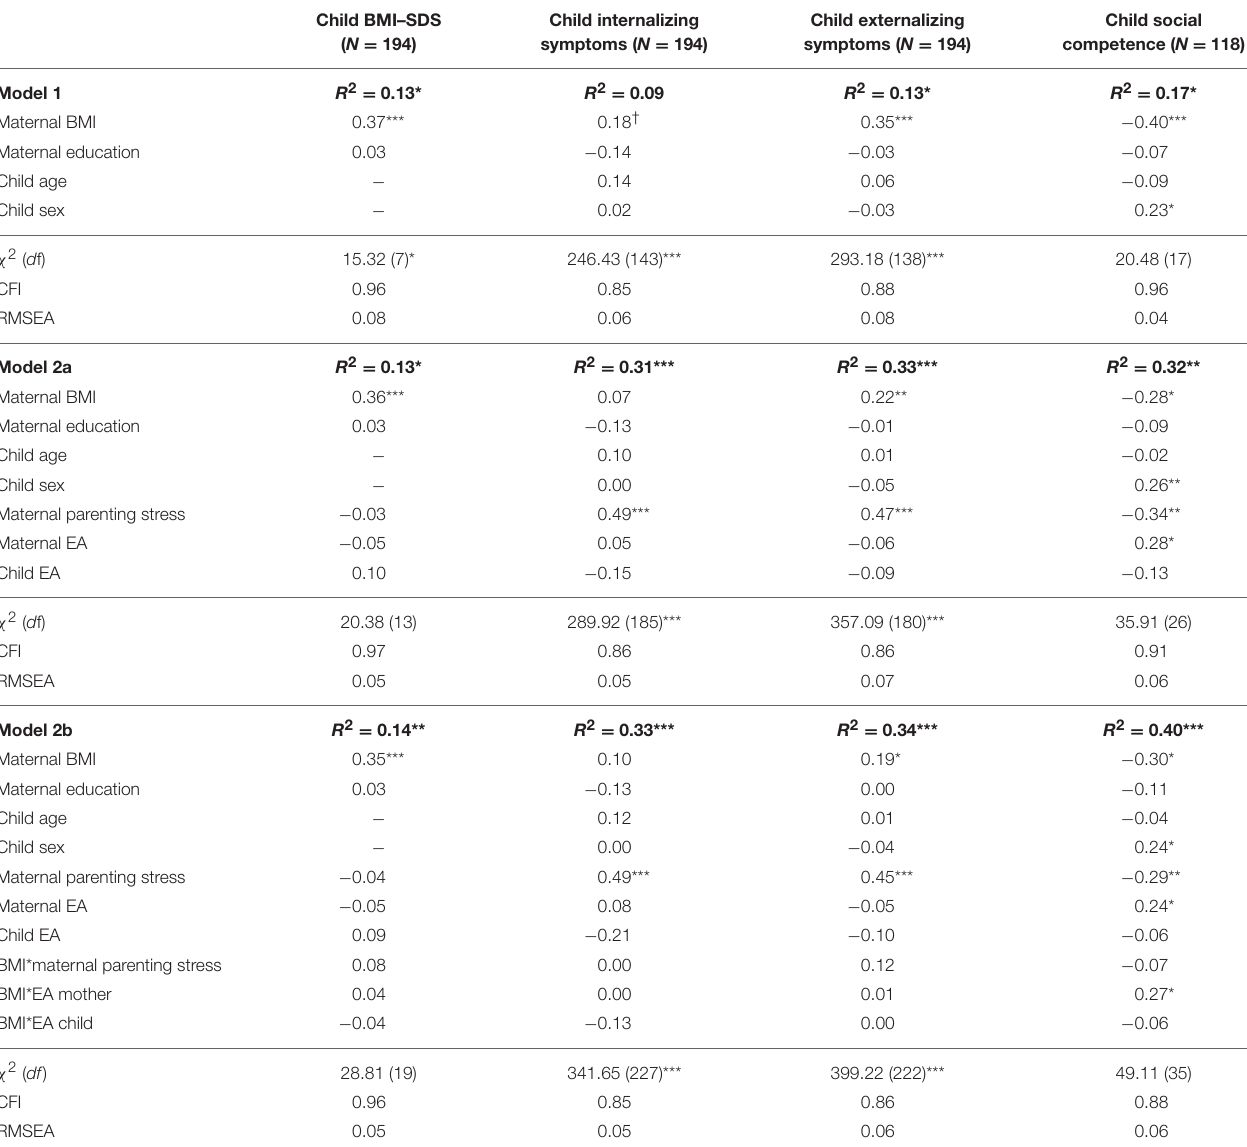
TABLE 4 | Prediction of the level at t 3 (intercept) of children’s BMI–SDS, internalizing and externalizing symptoms, as well as social competence (standardized regression coefficients β ) and model fit indices of latent growth models and latent regression